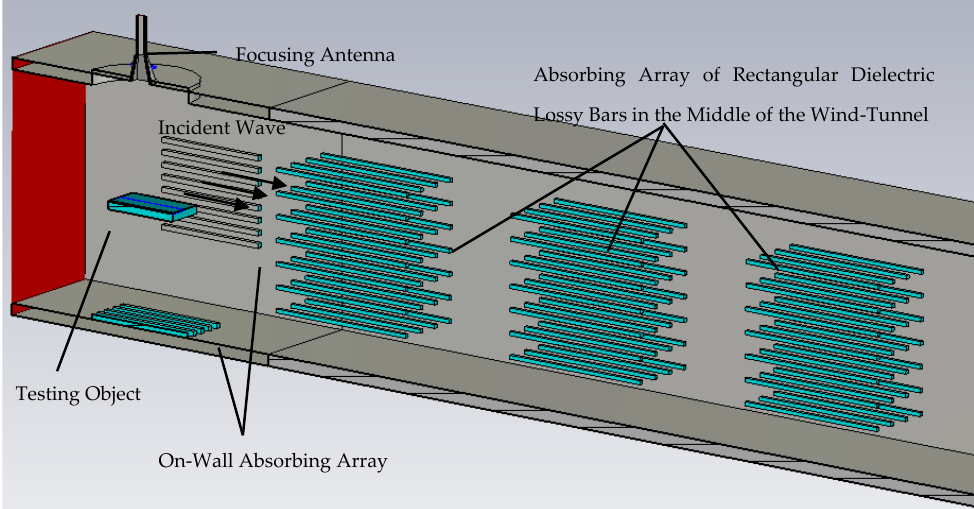
Figure 1. Schematic diagram of microwave radiation effect experiment in wind tunnel. A matching port is assumed at the left end for simplicity. The right end extends periodically toward the end of the wind tunnel.